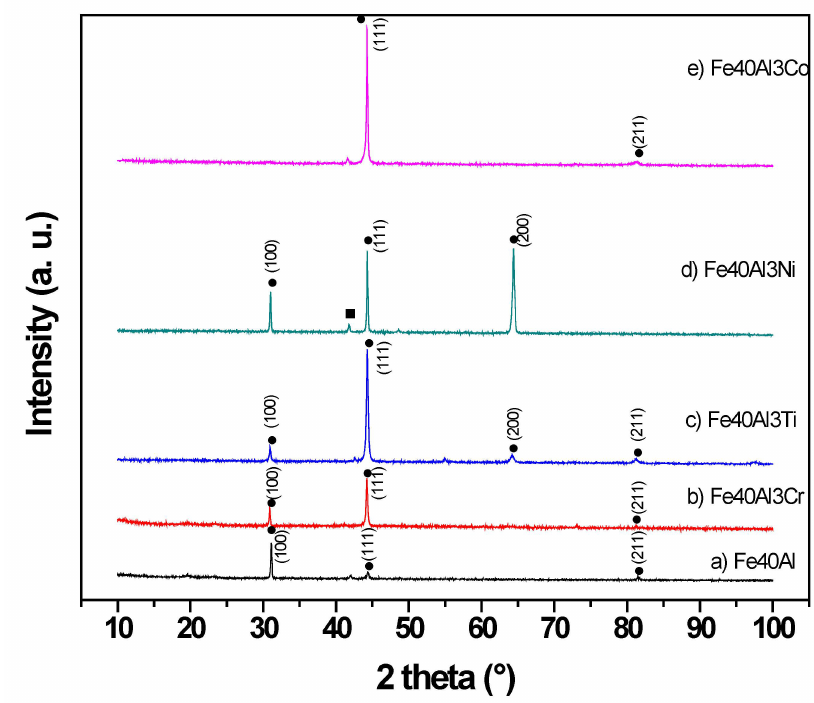
Figure 1. X-ray di ff raction profiles of the as-cast intermetallic alloys ( a ) Fe40Al, ( b ) Fe40Al-3Cr, ( c ) Fe40Al-3Ti, ( d ) Fe40Al-3Ni and ( e )